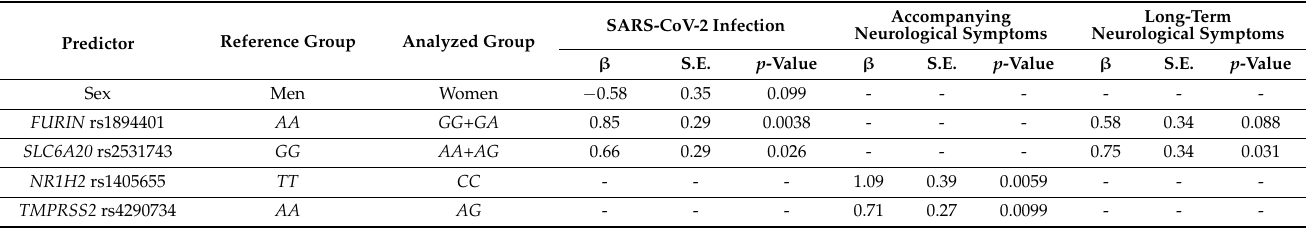
Table 3. Logistic regression models demonstrating the combined effects of the examined SNPs on COVID-19 susceptibility and neurological